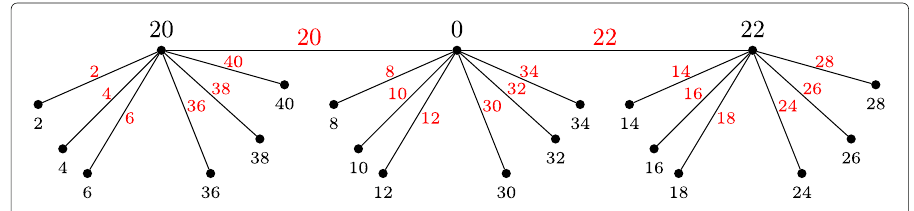
Fig. 7 Edge even graceful labeling of the graph P 3 (cid:4) K 6